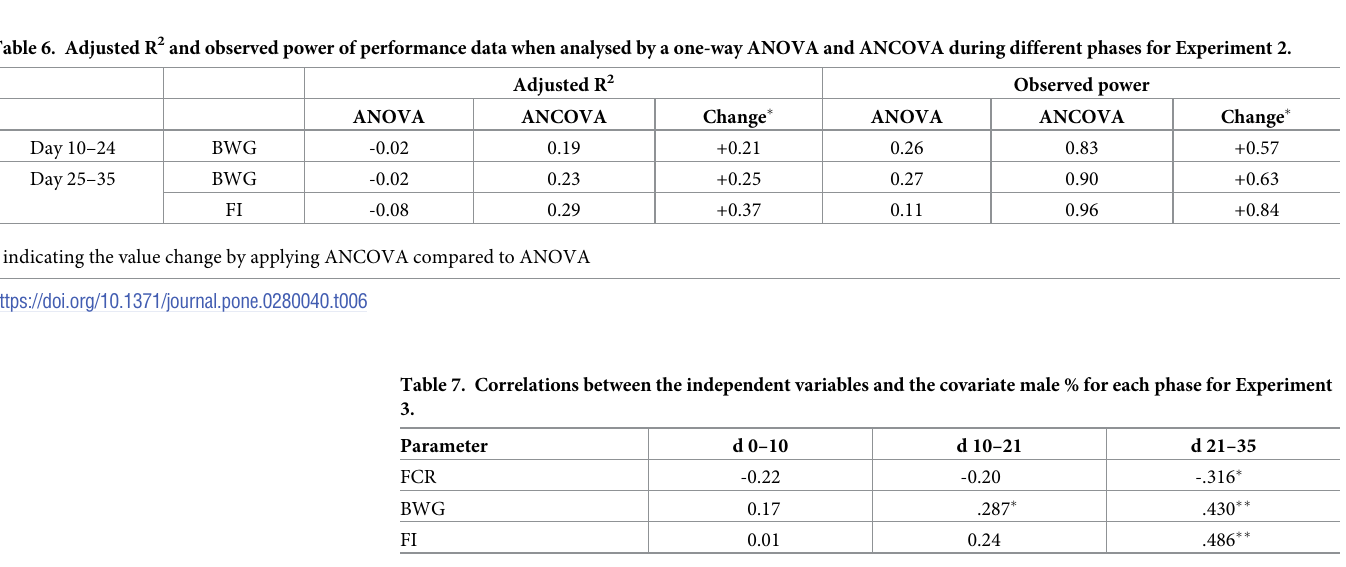
�� . Correlation is significant at the 0.01 level (2-tailed). � . Correlation is significant at the 0.05 level